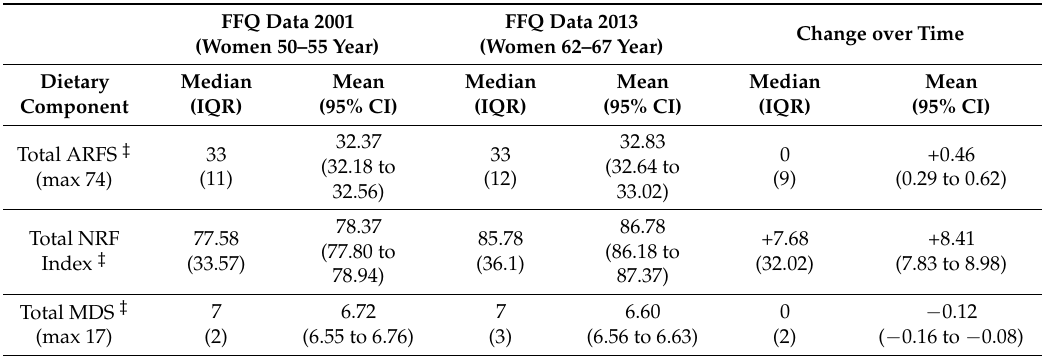
Table 2. Summary and comparison of Diet Quality in 2001 and 2013: Australian Recommended Food Score, Nutrient Rich Foods Index and Mediterranean Diet Score.